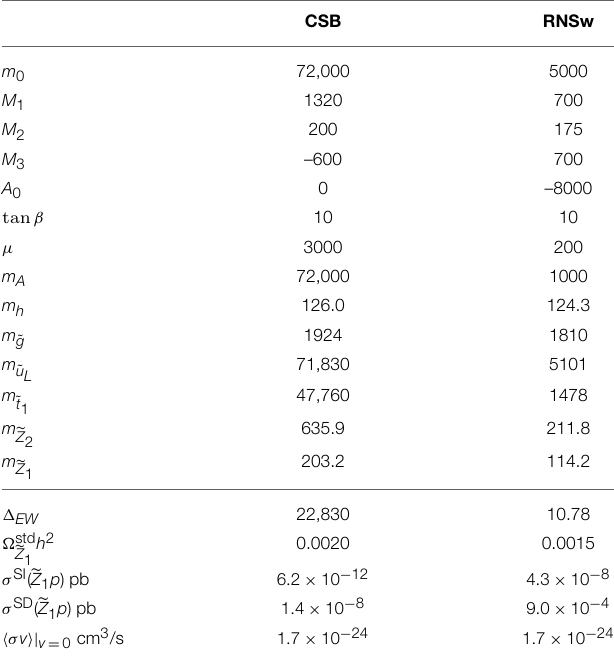
TABLE 1 | Masses and parameters in GeV units for two benchmark points computed with Isajet 7.83 and using m t = 173 . 2 GeV. CSB RNSw m